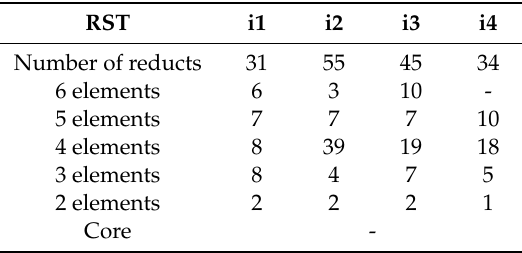
Table 11. Number, size, and cores of designated reducts designated using the RST method for the selection of sections of watercourses to the scale of 1:50,000. RST i1 i2